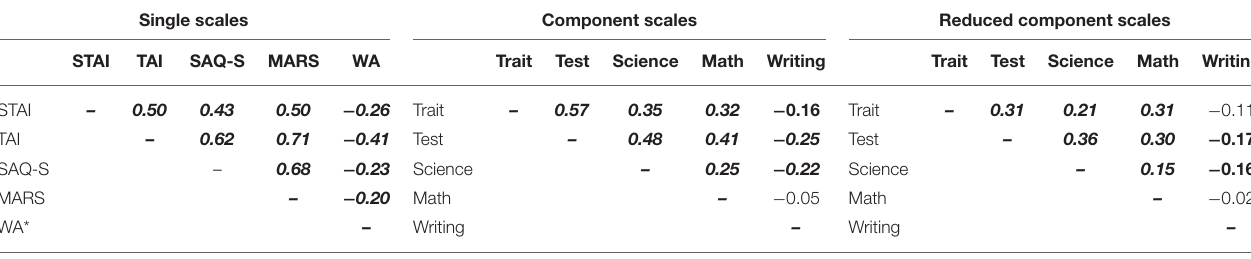
TABLE 4 | Correlations between each domain of academic anxiety: math, science, writing, test, and trait for Study 1. Single